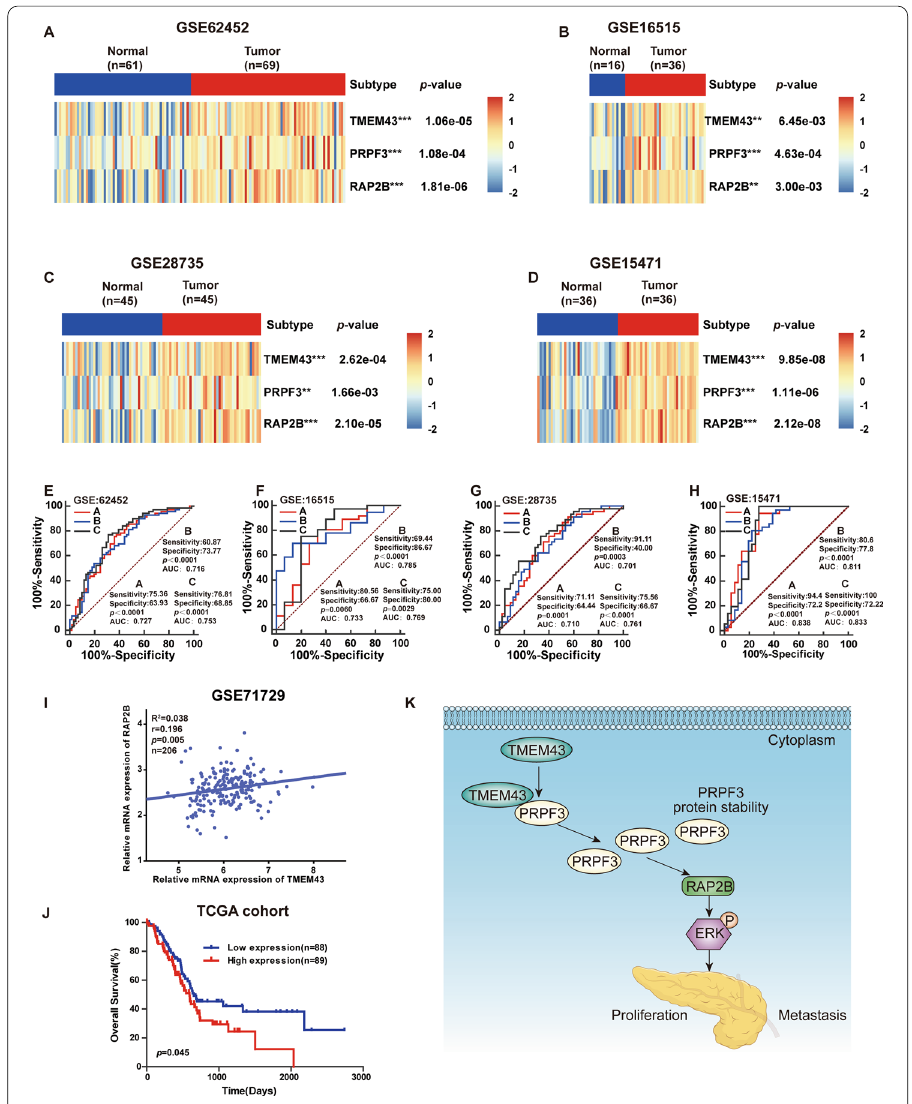
Fig.7 The clinical significance of the TMEM43/PRPF3/RAP2B axis in pancreatic cancer. A – D The mRNA levels of TMEM43, PRPF3, and RAP2B in pancreatic cancer samples compared with the corresponding control samples in the GSE62452, GSE16515, GSE28735, and GSE15471 datasets. E – H Receiver operating characteristic (ROC) curves were used to analyze the diagnostic value of TMEM43, PRPF3, and RAP2B. I The correlation of TMEM43 and RAP2B was analyzed in the GSE71729 dataset. J Kaplan–Meier curve analysis showed the correlation of RAP2B mRNA levels with patient survival using the TCGA dataset. K Illustration showing that TMEM43 promotes pancreatic cancer proliferation, migration, and invasion by the PRPF3/ RAP2B/ERK